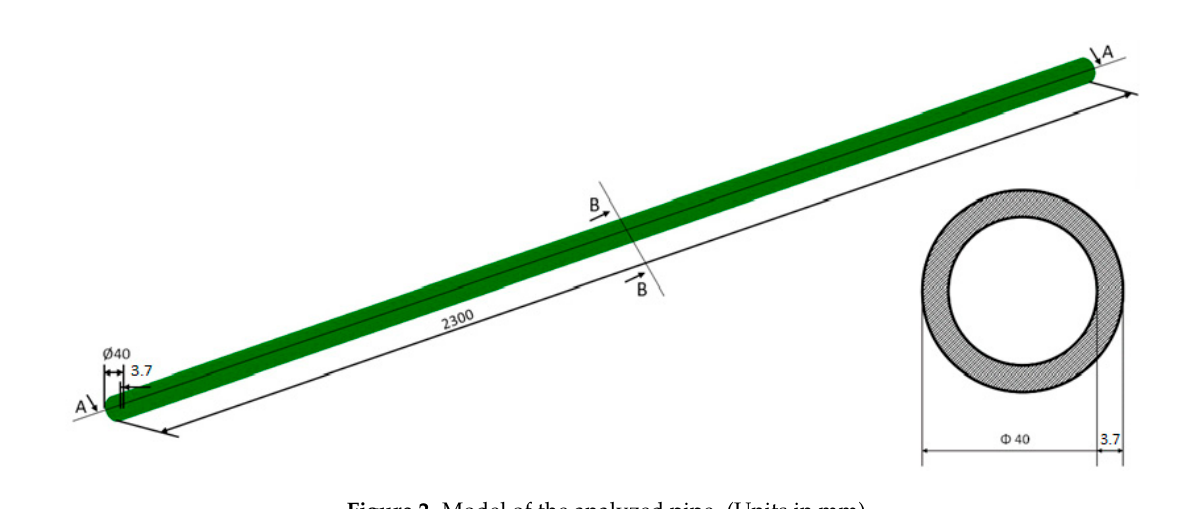
Figure 2. Model of the analyzed pipe. (Units in mm).